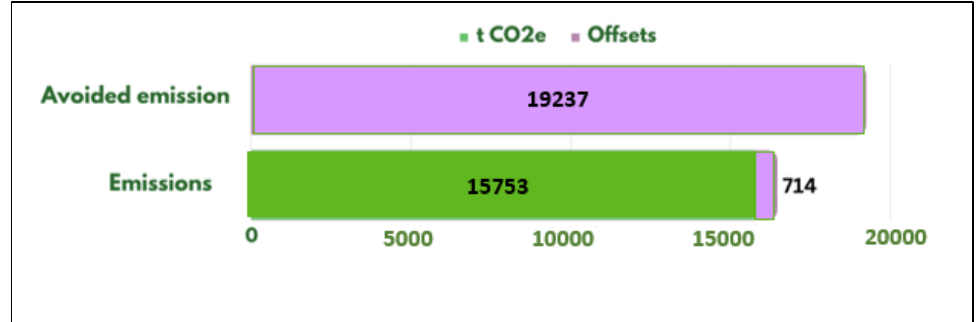
Figure 5. Comparison between avoided and emitted emissions with offsets at the University of Bologna in 2020.